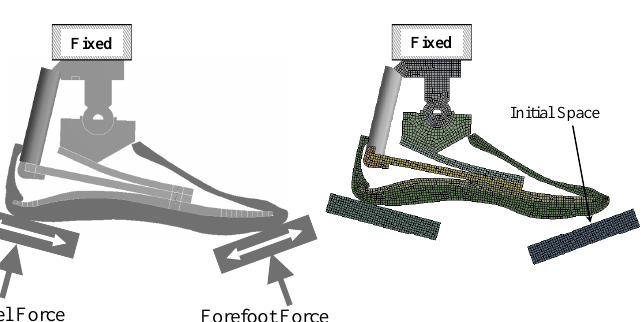
Figure 18. ISO 10328 cyclic test configuration: the heel platform was inclined at − 15°, while the forefoot platform had an inclination of 20°. The heel and the forefoot forces followed the paths given in Figure